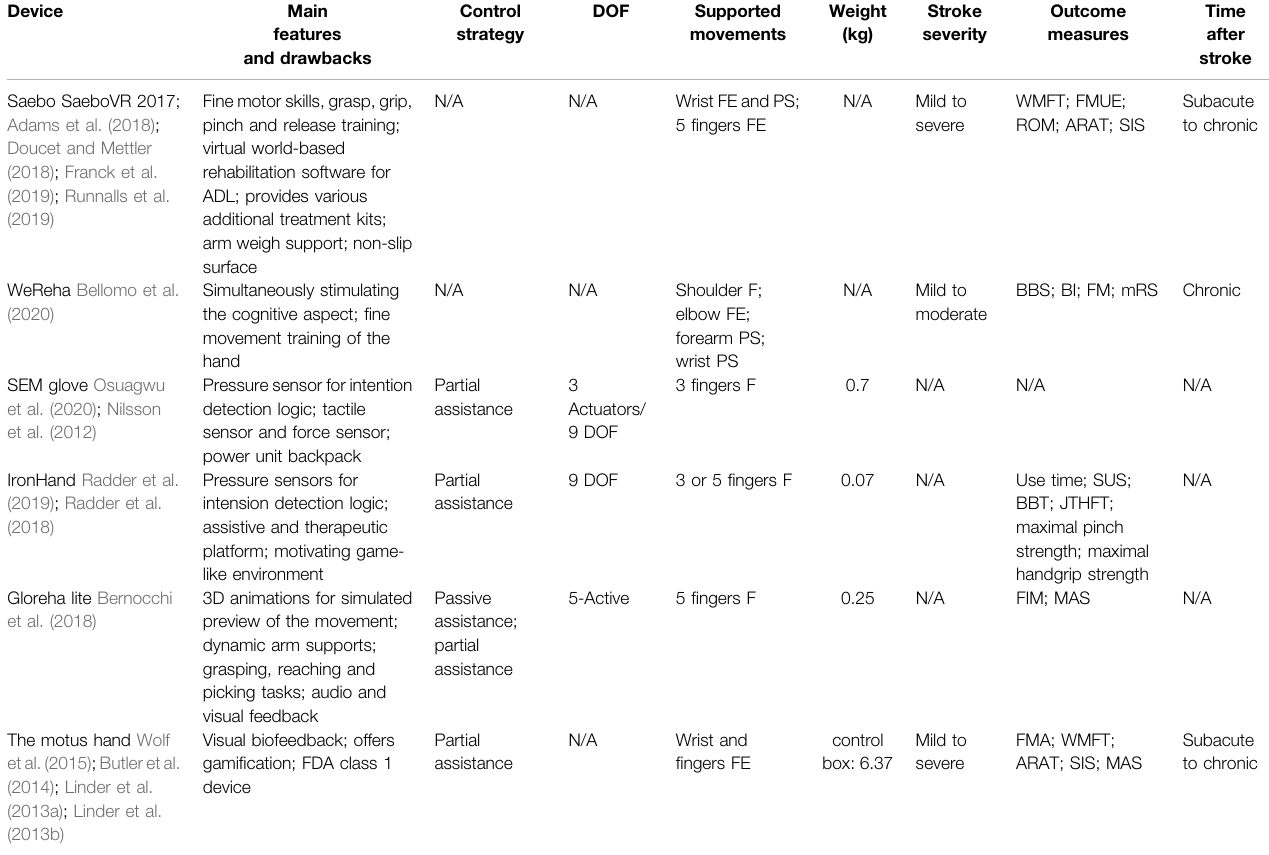
TABLE 2 | Summary of commercialized robotic systems for home-based upper-limb rehabilitation.